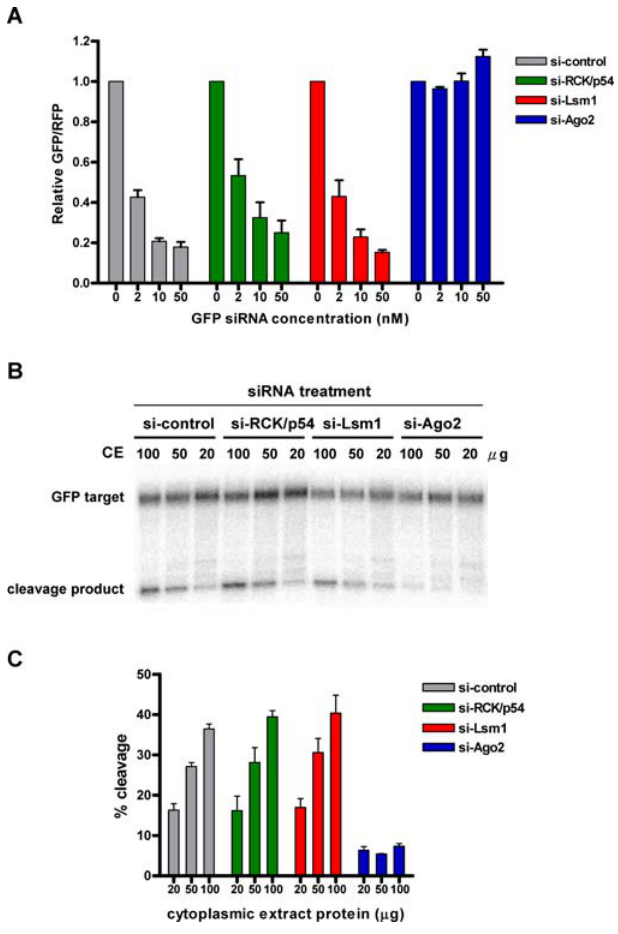
Figure 6. Depletion of RCK/p54 Has No Significant Effect on RNAi Activity In Vivo and In Vitro (A) In vivo effect of depleting RCK/p54, Lsm1, and Ago2 on siRNA dose- dependent RNAi activity. HeLa cells were transfected with siRNAs against CDK9 mismatch (control), RCK/p54, Lsm1, or Ago2. 24 h later cells were transfected again with EGFP and RFP reporter plasmids and varying amounts (2, 10, and 50 nM) of siRNA against EGFP. 24 h after the second transfection, RNAi efficiencies were analyzed (see Materials